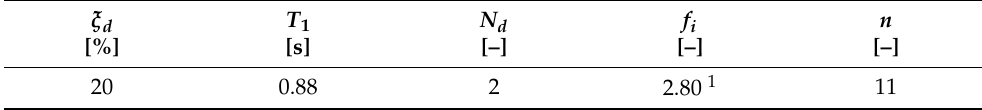
Table 2. Supplemental damping system